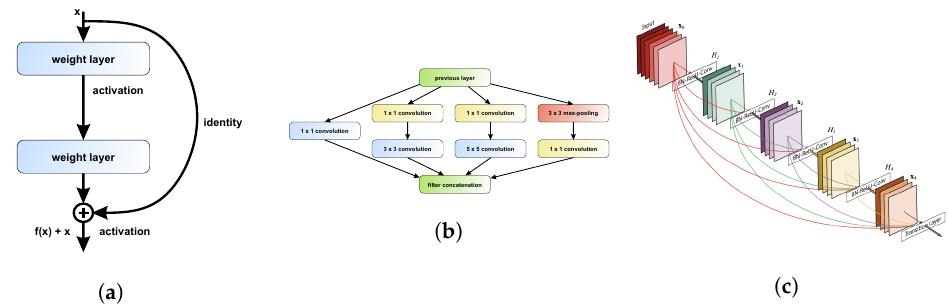
Figure 11. CNN-based neural network architecture element: ( a ) a sample residual block explaining the idea behind ResNet model [35]; ( b ) the general idea of Xception network [36]; ( c ) schematic diagram of DenseNet architecture